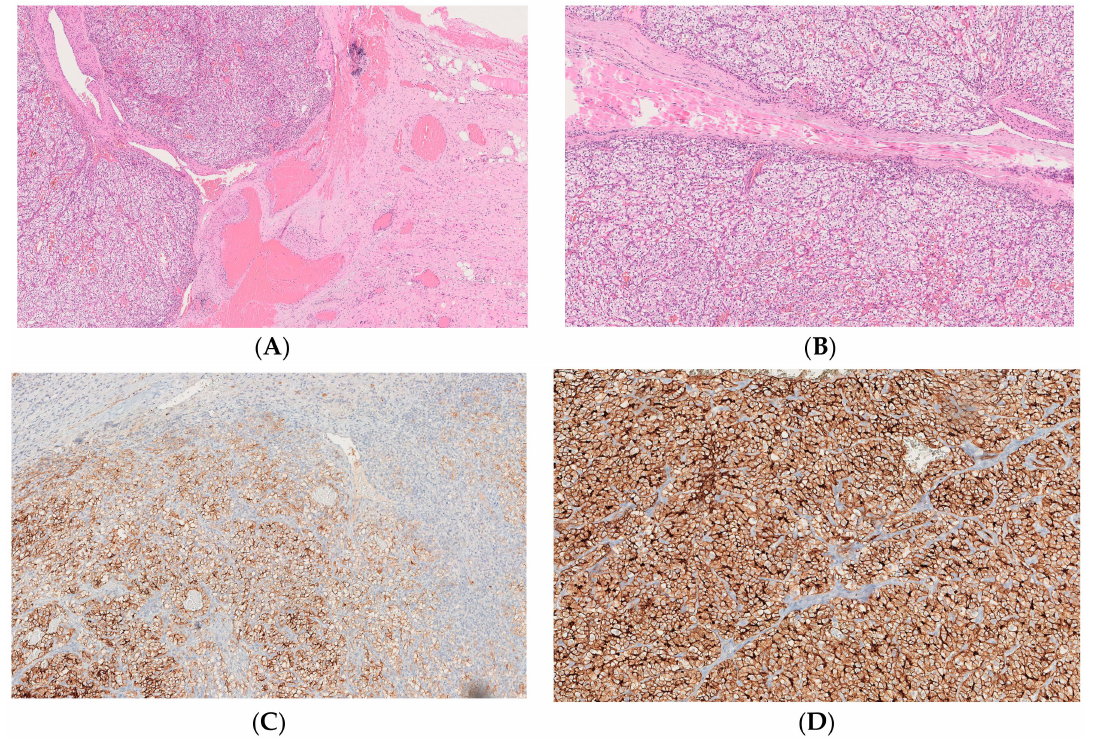
Figure 2. Histopathological examination showing a metastatic lesion consistent with RCC. ( A , B ) Hematoxylin and eosin staining; ( C , D )